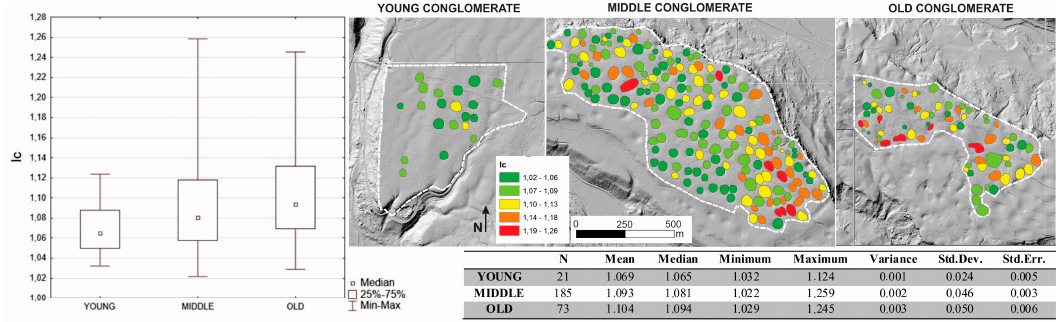
Figure 10. The circularity of dolines’ planar shapes for conglomerates by age.